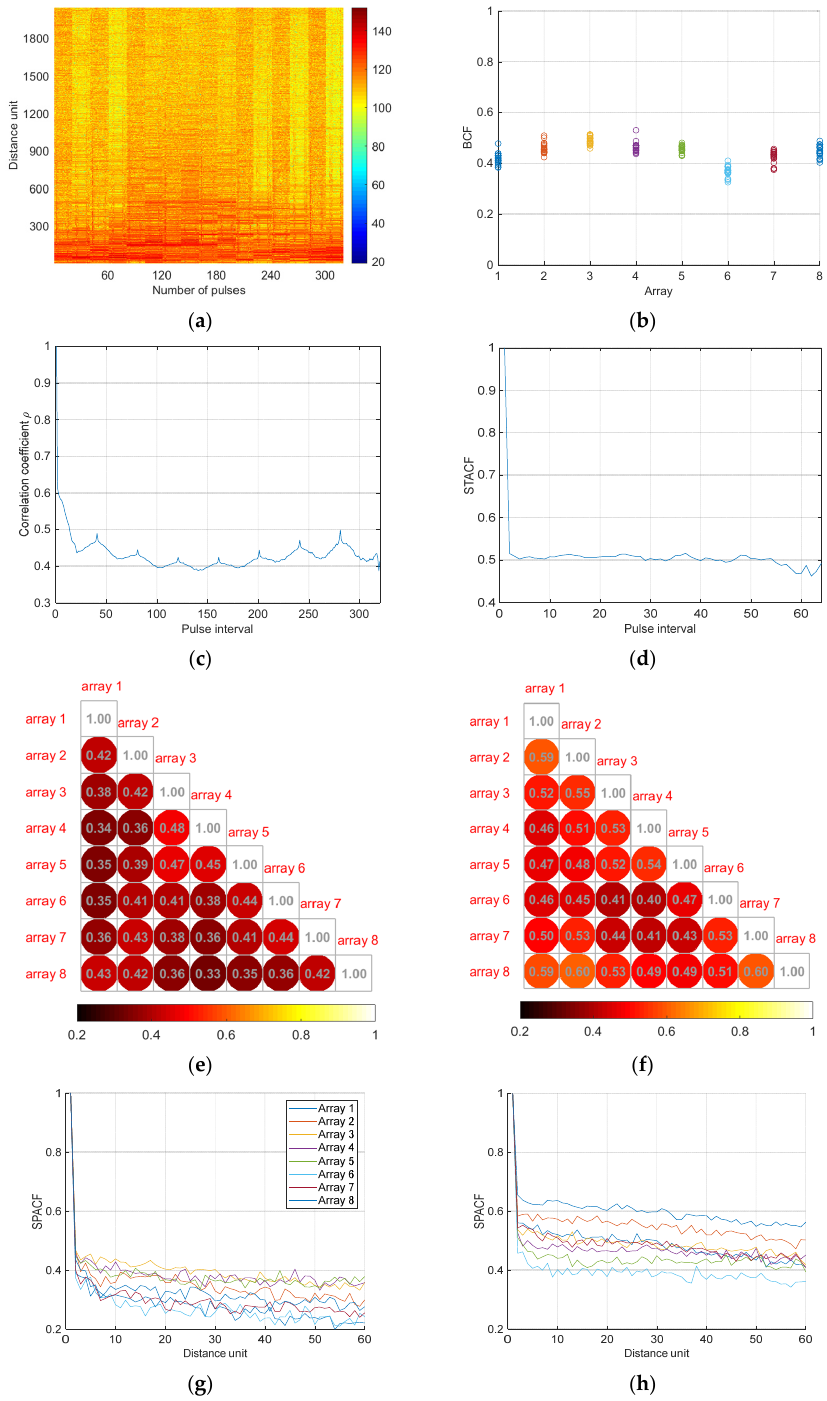
Figure A1. Correlation characteristic map of UCA radar ground clutter data. ( a ) Range time diagram of full-channel pulse splicing data; ( b ) Beam correlation diagram of eight channels of radar; ( c ) The variation diagram of inter pulse correlation coefficient corresponding to ( a ); ( d ) Intra-frame correlation function diagram of C1 beam for channel 1; ( e ) Azimuth correlation matrix diagram of C1 beam; ( f ) Azimuth correlation matrix diagram of C2 beam; ( g ) Range autocorrelation of eight channels of the C1 beam; ( h ) Range autocorrelation of eight channels of the C2